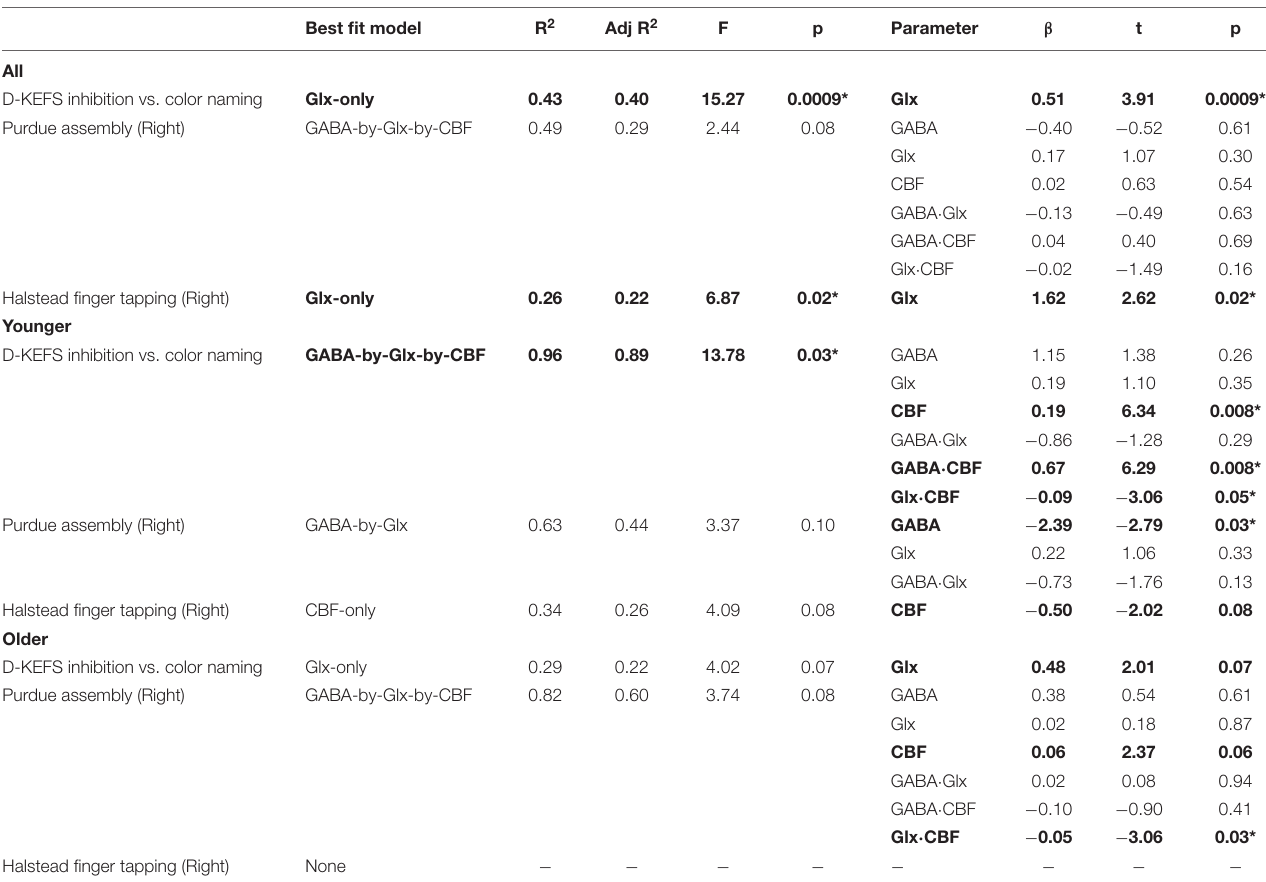
TABLE 4 | Best fit neurophysiological model for subtests of D-KEFS, Purdue, and